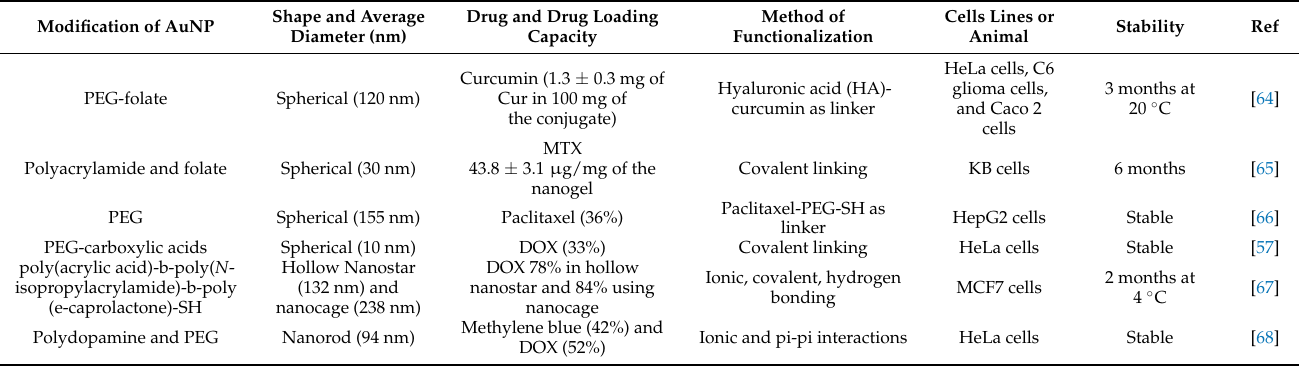
Table 1. Application of Au-polymer hybrid nanomaterials for drug